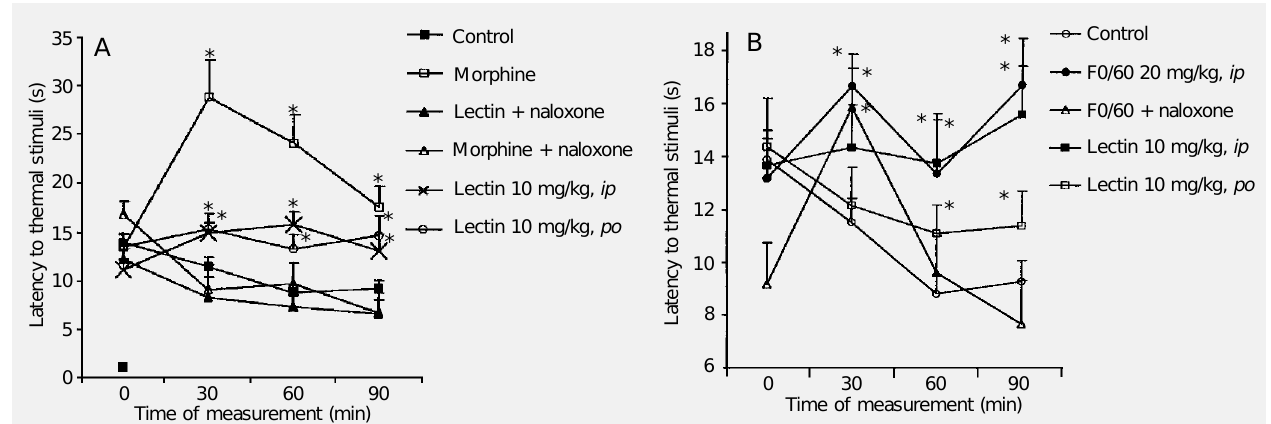
Figure 3. Possible involvement of the opioid system in the antinociceptive effects of F0/60 and lectin fractions from Bryothamnion seaforthii (A) and B. triquetrum (B) in the hot-plate test in mice. Latency to respond to thermal stimuli (mean ± SEM) recorded for 8 to 10 mice. Latency times were